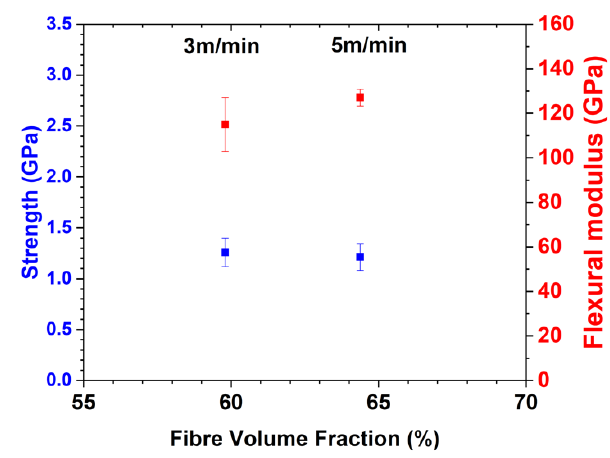
Figure 10. Flexural performance of the UD-CFRP plates.